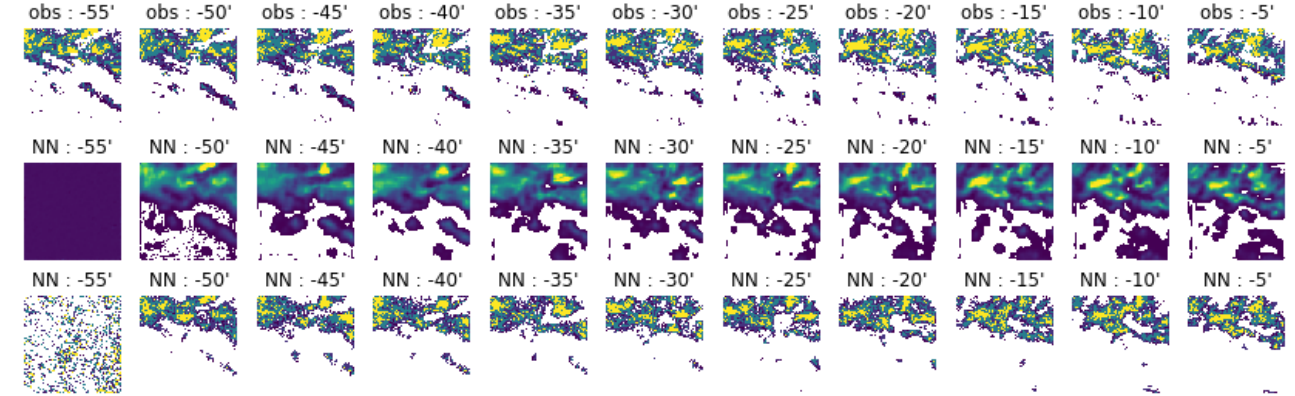
Figure 3. Sequence of 12 images at 5’ intervals of the precipitation field during the hour preceding the nowcast. The first row shows the observed data ( obs ), the second row the estimated values by the PredNet ( NN ), and the third row one of the scenario fields obtained applying the spatial downscaling process described in the paragraph 2.3 to the corresponding fields of the second row.